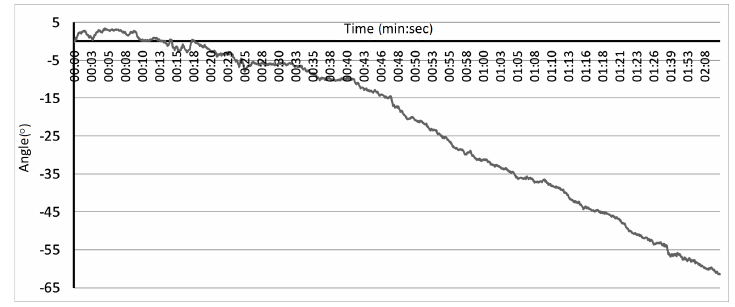
Figure 7. Gyroscope drift for non-moving